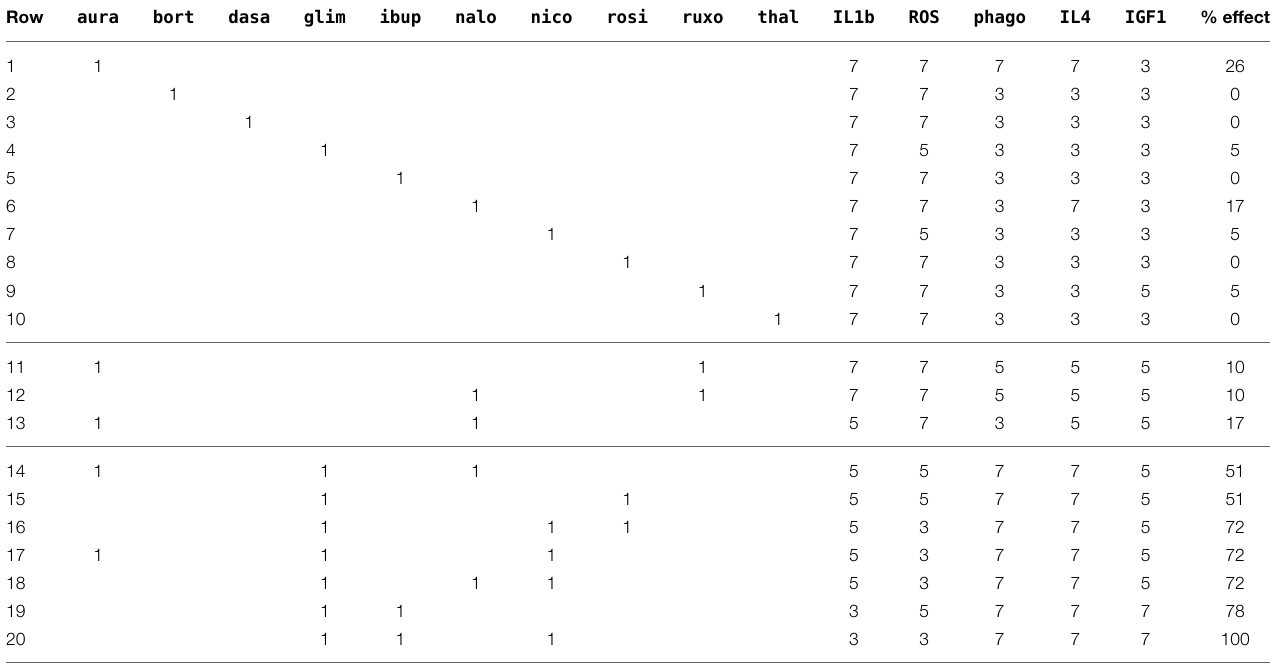
TABLE 3 | Model endpoints starting from the old initial condition with Ab(1) and LPS(1) and with drugs either singly or in specific combinations. Row